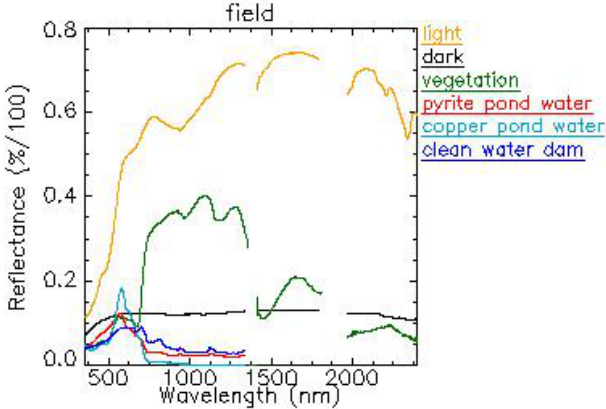
Figure 6. Field spectra from calibration targets used for atmospheric corrections with the Empirical Line